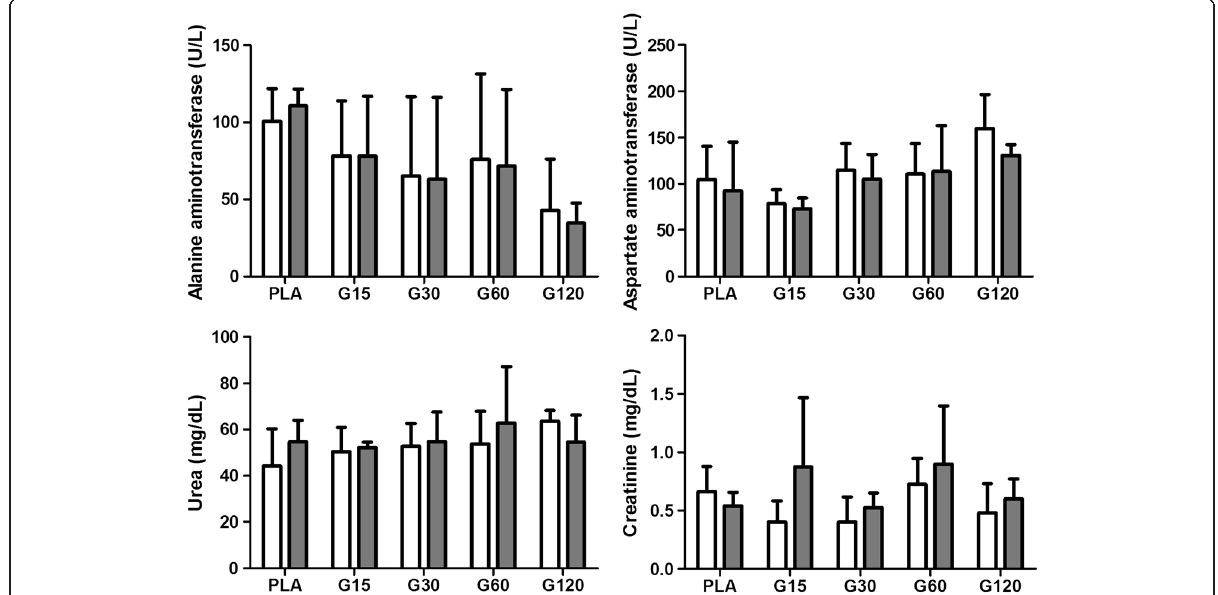
Figure 4 Effects of different doses of MVIIC on biochemical parameters. Mean number ± SD of alanine aminotransferase (ALT) (U/L), aspartate aminotransferase (AST) (U/L), urea (mg/dL) and creatinine (mg/dL) in different times (preoperatively and eight days after injection) ( p< 0.05). Controls were injected with sterile water (PLA) and other groups received different doses of MVIIC (15, 30, 60 and 120 pmol). ALT, AST, urea and creatinine normal values are, respectively, 19 – 48 U/L, 63 – 175 U/L, 10.7-20 mg/dL and 0.3-0.5 mg/dL, as described by Giknis and Clifford [39].